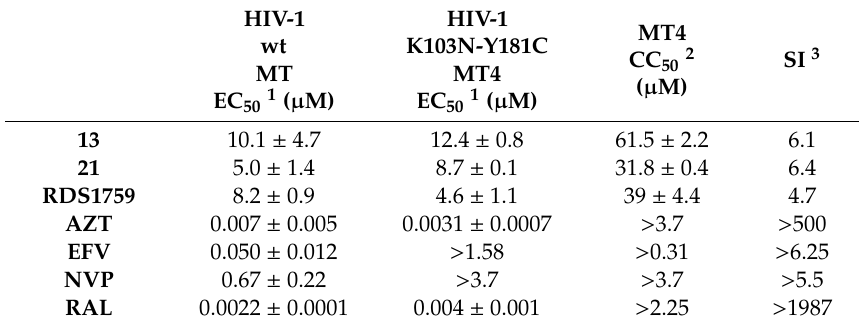
Table 1. Antiviral activity of compounds against wt NL4-3 and NNRTI-resistant HIV-1